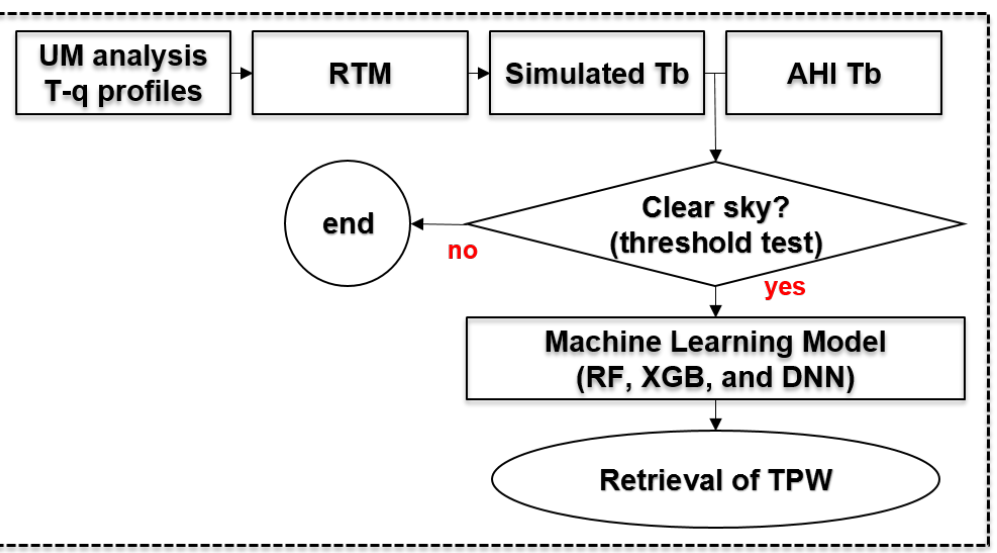
Figure 4. Process flow of the proposed machine learning (random forest (RF), extreme gradient boosting (XGB), and deep neural network (DNN))-based TPW retrieval models from AHI observations under clear-sky conditions.